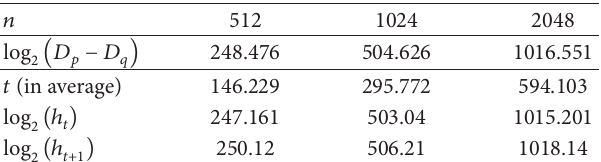
Table 1: The improvement of EPF on 𝑝 + 𝑞 , where 𝑝 and 𝑞 are balanced.